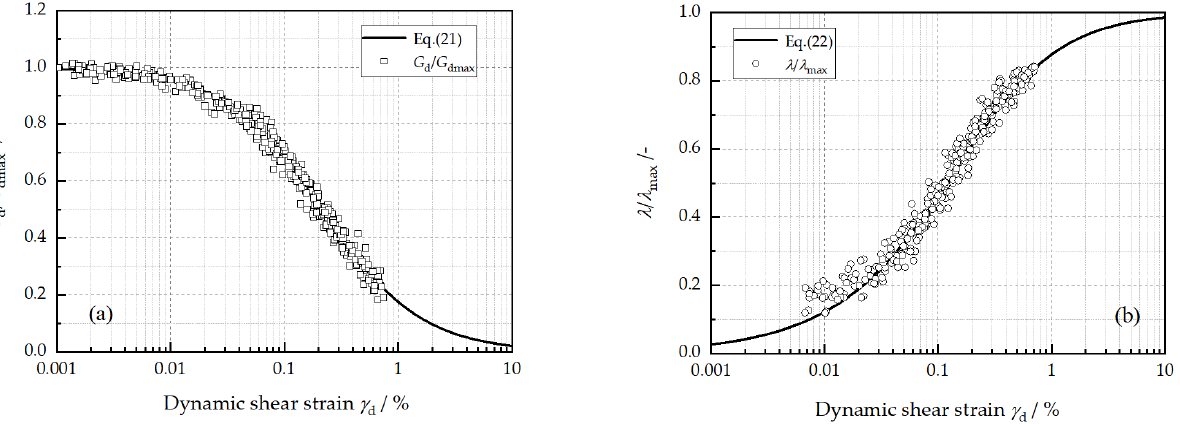
Figure 16. Normalized data versus dynamic shear strain: ( a ) normalized dynamic shear modulus, ( b ) normalized damping ratio.